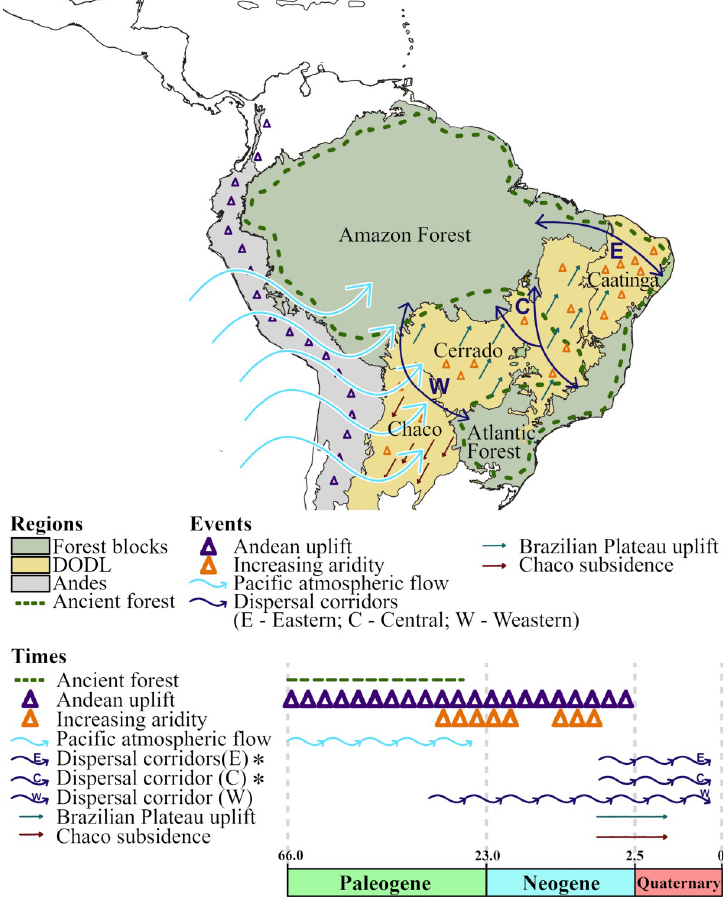
Fig 1. Summary of important events underlying the expansion of the diagonal of open/dry landscapes (DODL). The location of the continuous ancient forest that was subsequently splitted into the actual Amazon and Atlantic forests (dashed green line) is based on Bigarella et al. [18]. Below the map, times and periods are based on Cohen et al. [25]. The asterisks indicate times established on the literature [9, 11, 26] with recent works contesting them [27–29]. Map source: Natural Earth